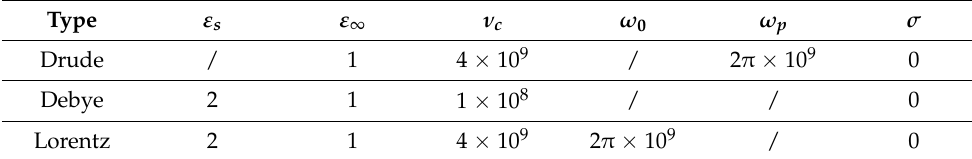
Table 1. Parameters in Drude, Debye, and Lorentz models.